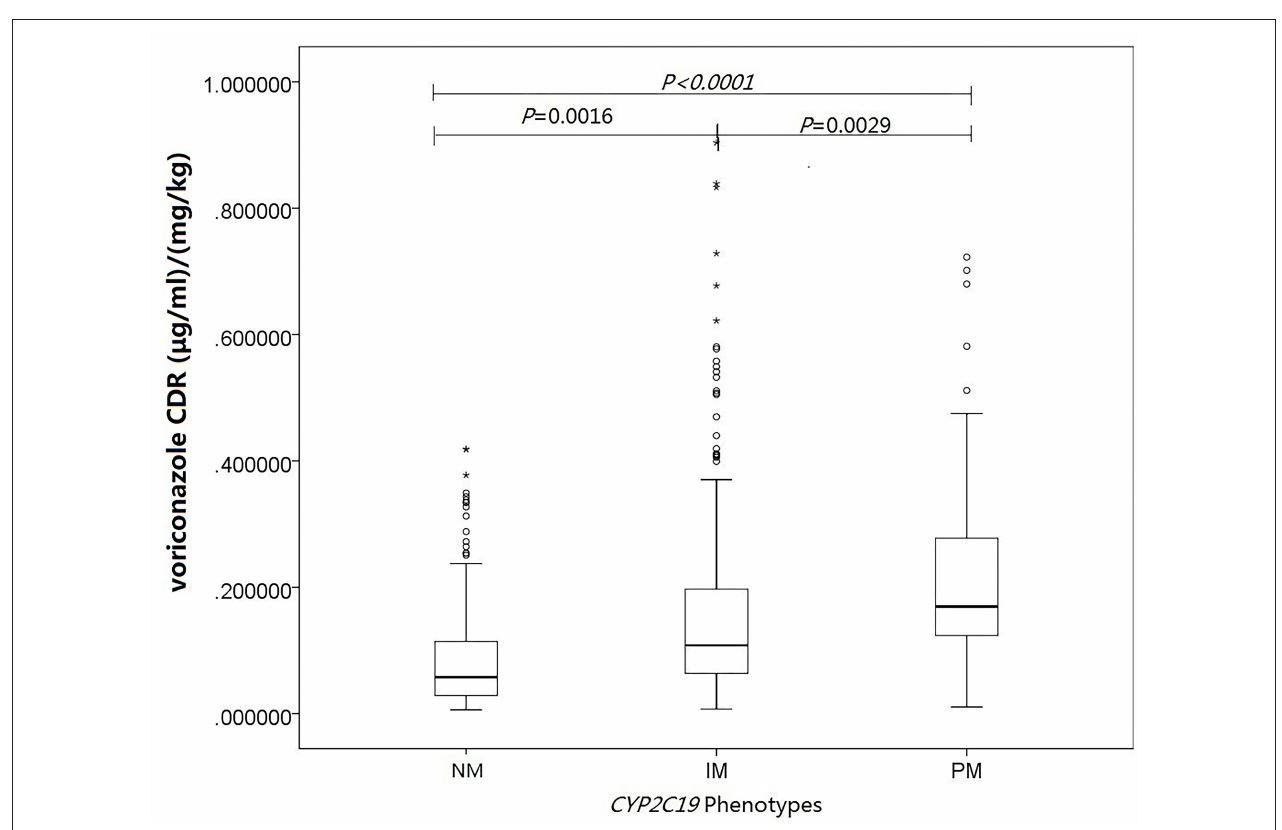
FIGURE 1 | Influence of CYP2C19 genotype and other covariates on voriconazole concentrations. Linear mixed-effects regression analysis of the relationship between CYP2C19 phenotypes and voriconazole concentration-to-dose ( µ g/ml per mg/kg). The asterisks represent extreme outliers.